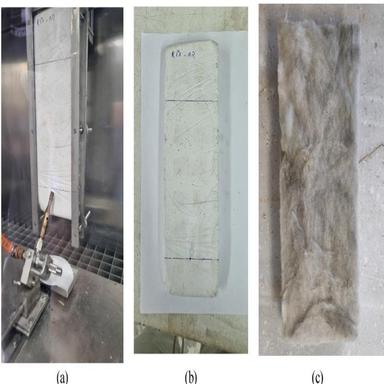
Fire test samples: (a) E− 0.7-KPA-EC test; (b) Flame mark in sample after being tested; (c) Recycled Glass Wool fibre test sample.